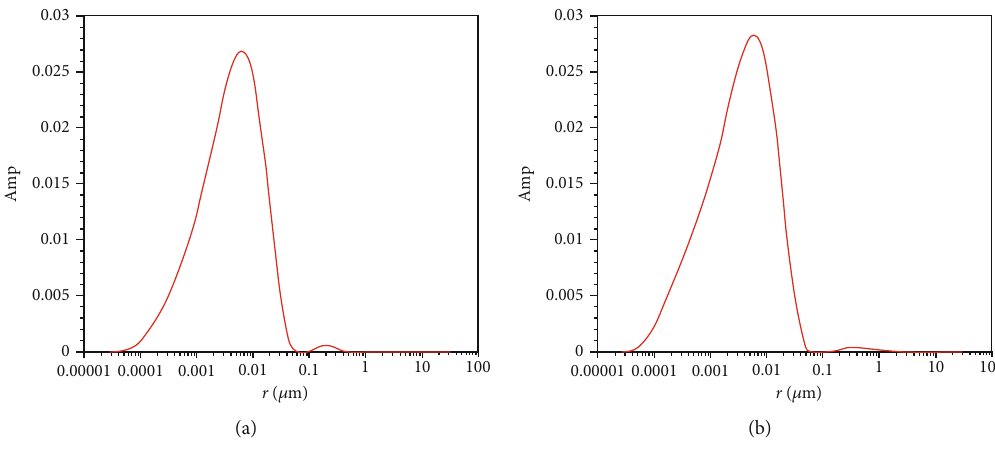
Figure 2: Pore size distribution. (a) Sample A. (b) Sample